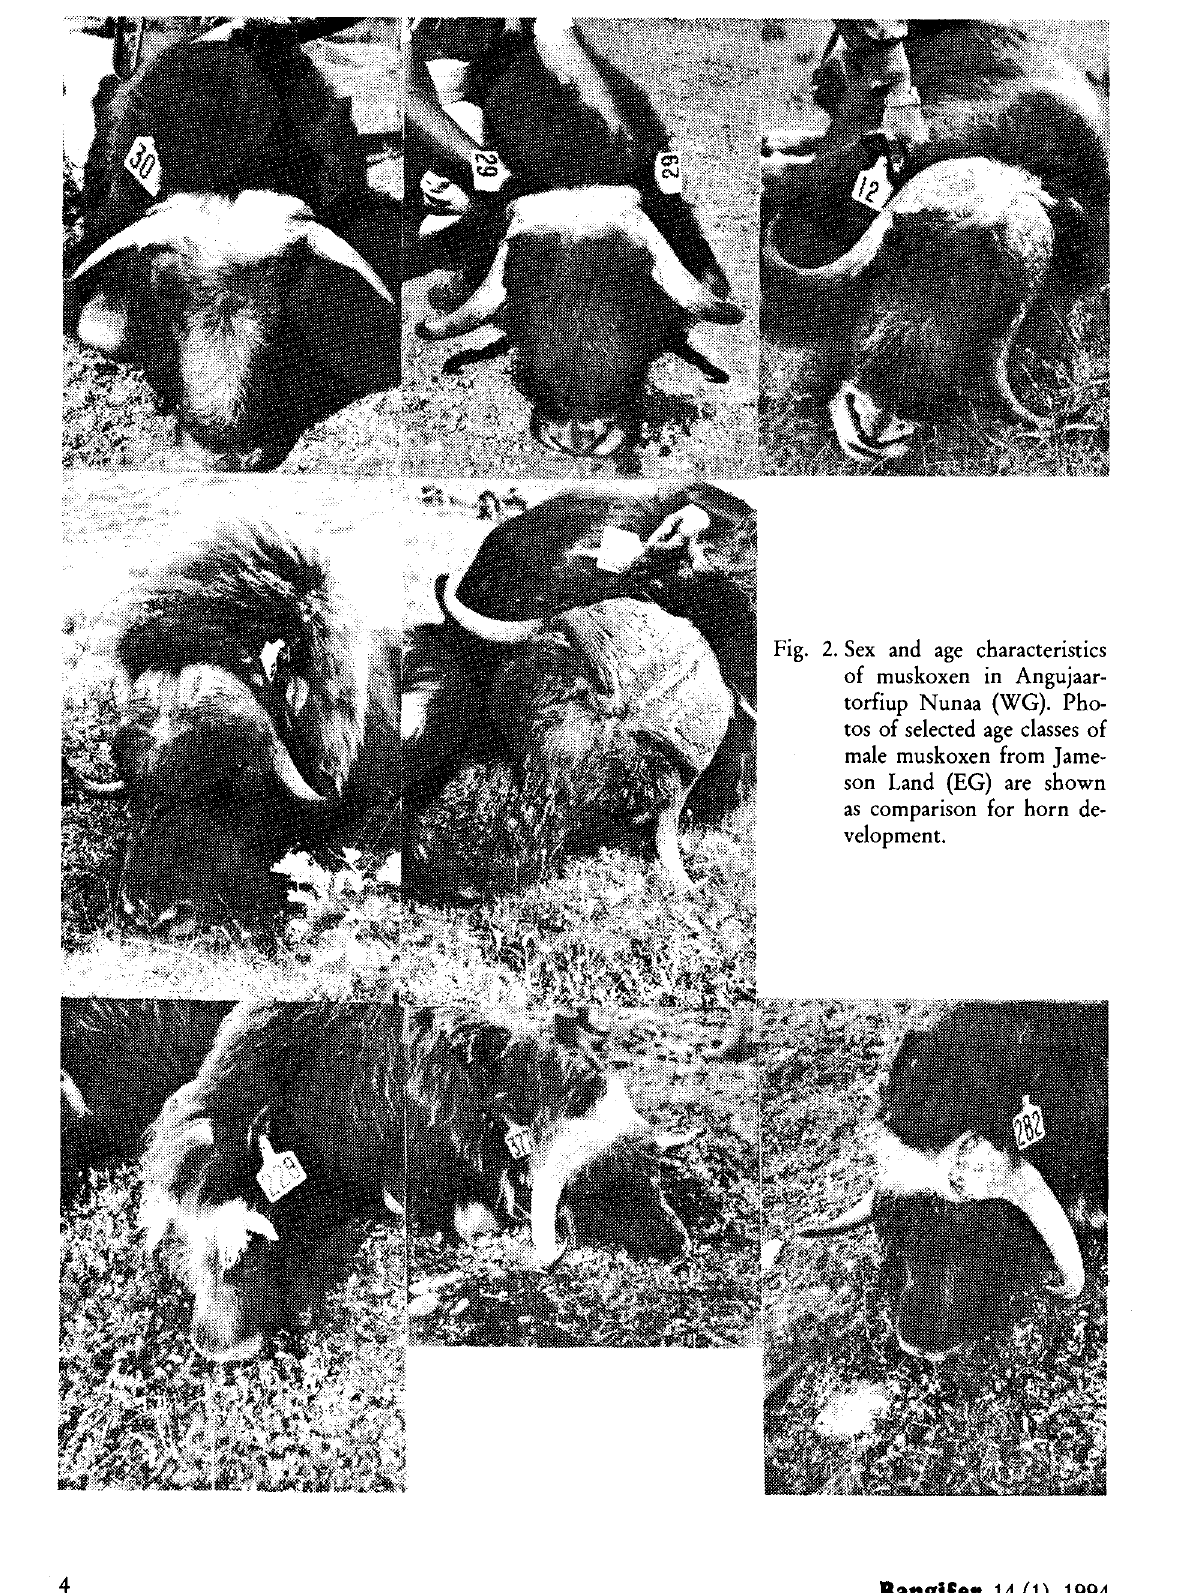
Fig. 2. Sex and age characteristics of muskoxen in Angujaar- torfiup Nunaa (WG). Pho tos of selected age classes of male muskoxen from Jame son Land (EG) are shown as comparison for horn de